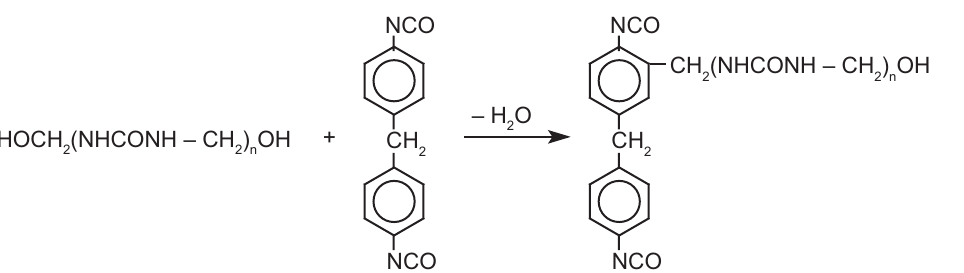
Figure 1 Reaction scheme of pMDI with methylol groups of UF resin Slika 1 . Shema reakcije pMDI-ja s metilol grupama UF